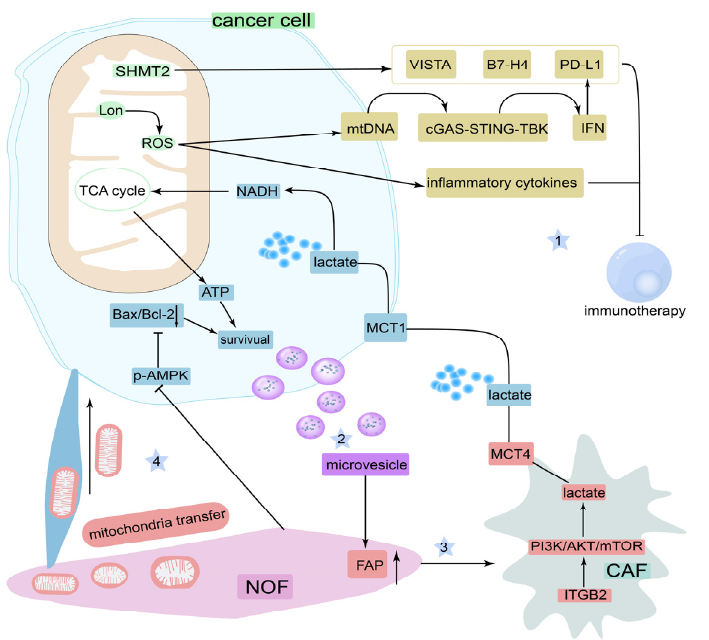
Figure 7. Communication between mitochondria of OSCC cells and immune cells or fibroblasts of the TME. (1) mitochondria suppress immunotherapy via the expression of serine hydroxymethyltransferase 2 (SHMT2) and mitochondrial Lon protein (Lon). (2) OSCC cells cause the transformation of normal fibroblasts (NOFs) to cancer-associated fibroblasts (CAFs) by microvesicles. (3) CAFs promote OSCC survival by providing lactate. (4) NOFs contribute to OSCC cell survival by inhibiting AMPK activity and by transferring mitochondria to OSCC cells.